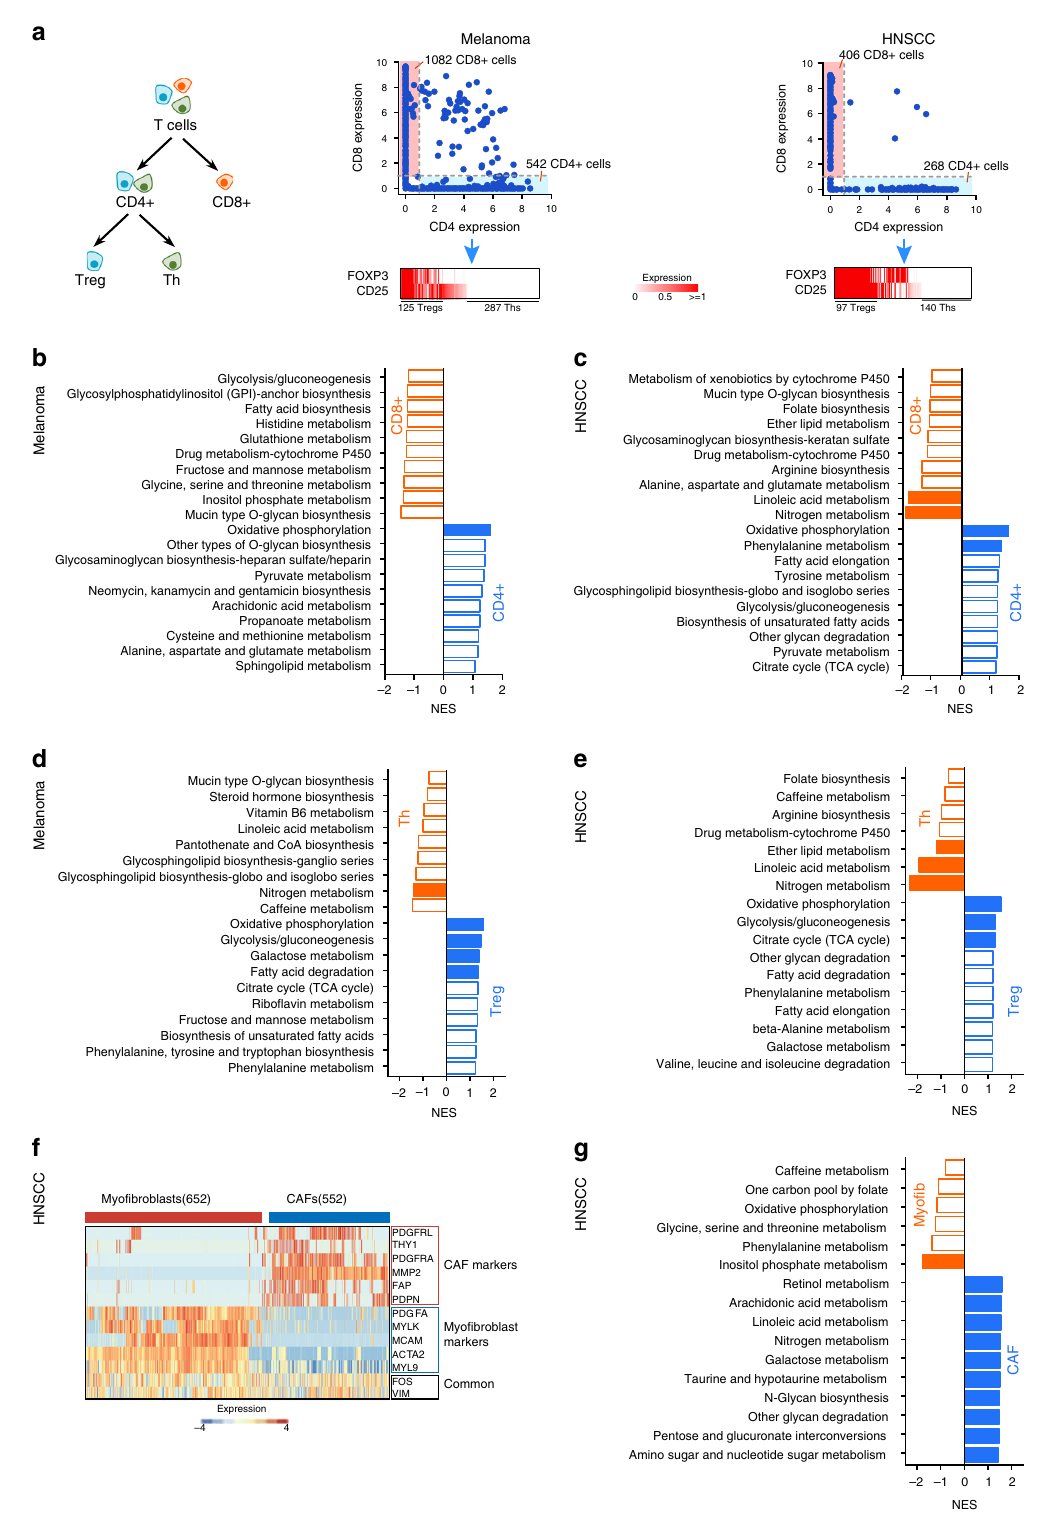
Fig. 5 Metabolic features of non-malignant cell subtypes. a Left panel: classi fi cation of T cells into CD4 + , CD8 + , regulatory T cells (Tregs) and T helper cells (Ths). Middle and right: expression levels of the gene markers used for separating T cell subtypes in melanoma (middle) and HNSCC (right) datasets. b Top 10 metabolic pathways enriched in CD4 + or CD8 + T cells in the melanoma dataset. Signi fi cantly enriched pathways with GSEA p -value < 0.05 are highlighted in red (higher in CD8 + ) or blue (higher in CD4 + ). c Same as in b but for the HNSCC dataset. d Top 10 metabolic pathways enriched in Tregs or Ths in the melanoma dataset. Signi fi cantly enriched pathways with GSEA p -value < 0.05 are highlighted in red (higher in Th) or blue (higher in Treg). e Same as in d but for the HNSCC dataset. f Gene markers and their expression levels used for classifying fi broblast cells in the HNSCC dataset into CAFs and myo fi broblasts. g Top 10 metabolic pathways enriched in CAFs or myo fi broblasts in the HNSCC dataset. Signi fi cantly enriched pathways with GSEA p -value < 0.05 are highlighted in red (higher in myo fi broblasts) or blue (higher in